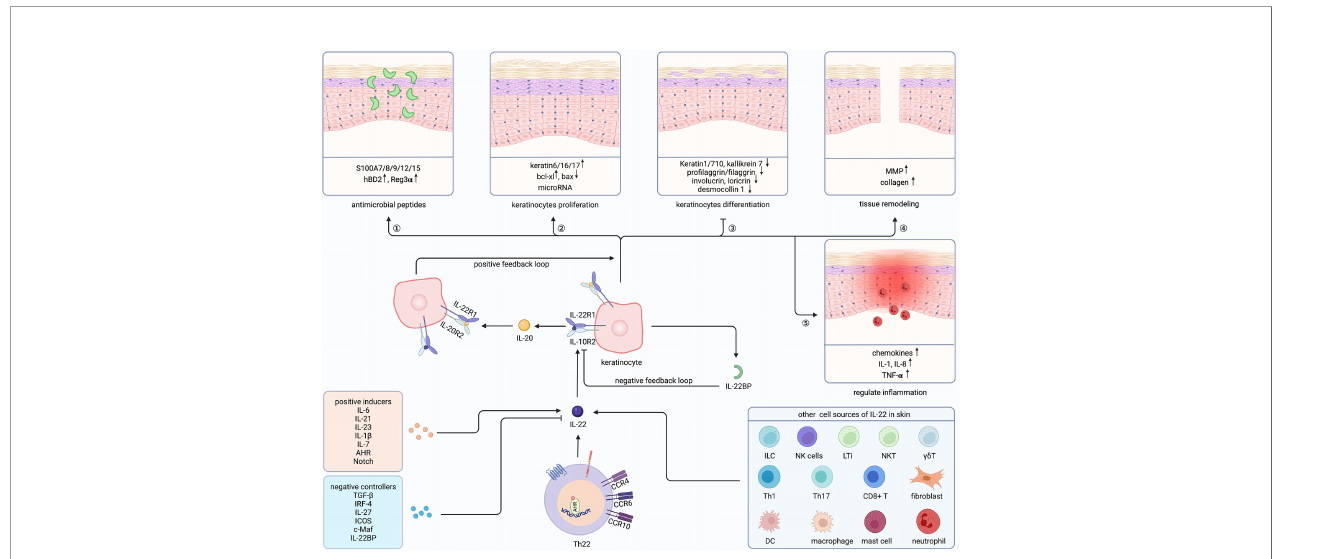
FIGURE 2 | Cutaneous biological roles of Th22 cells and IL-22. Th22 cells exert biological functions through its effector cytokine IL-22 in the skin. Besides, IL-22 could also be secreted by ILC, NK cells, LTi, NKT, gd T, Th1/17, CD8+ T cell, DC, macrophage, mast cell, neutrophil and fi broblast in the skin. Both positive inducers and negative controllers could regulate the expression of IL-22. IL-22 plays a vital role in Th22-mediated host defense by communicating with keratinocytes, promoting antimicrobial peptides and keratinocytes proliferation, inhibiting keratinocyte differentiation, and regulating tissue remodeling as well as in fl ammation. Furthermore, IL-22 could amplify its biological activities through a positive feedback loop by inducing IL-20 production in keratinocytes, which has similar effects on keratinocytes. ILC, innate lymphoid cell; NKT, natural killer T cell; LTi, Lymphoid tissue inducer; gd T, gamma-delta T cell; DC, dendritic cell; Th, T helper cell; IL-22BP, IL-22 binding protein; MMP, matrix metalloproteinases; AHR, aryl hydrocarbon receptor. Created with